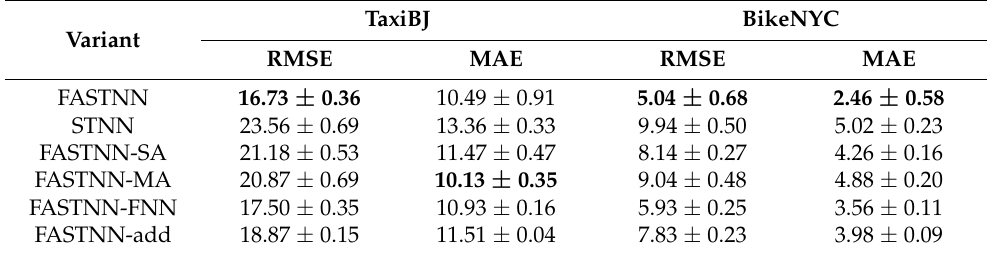
Table 4. Comparison of performance under different variants. (Note: Bold represents the best